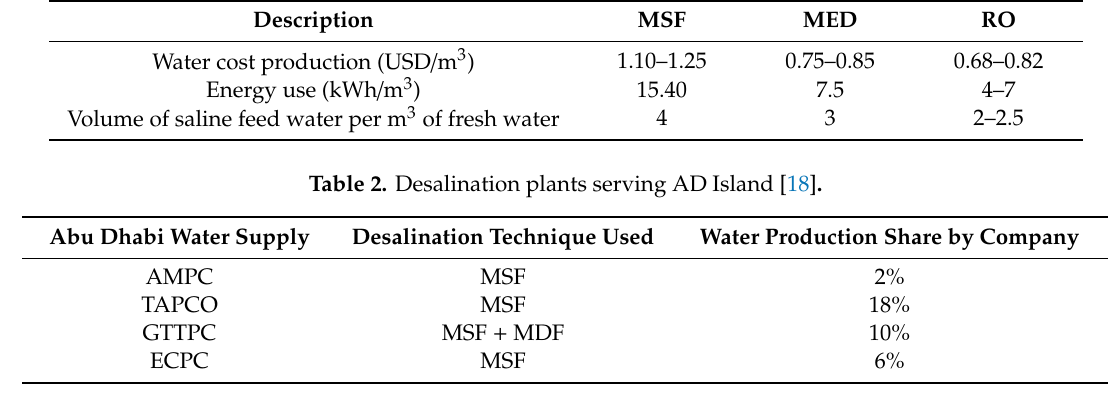
Table 1. Desalination techniques against financial and environmental impacts [20].